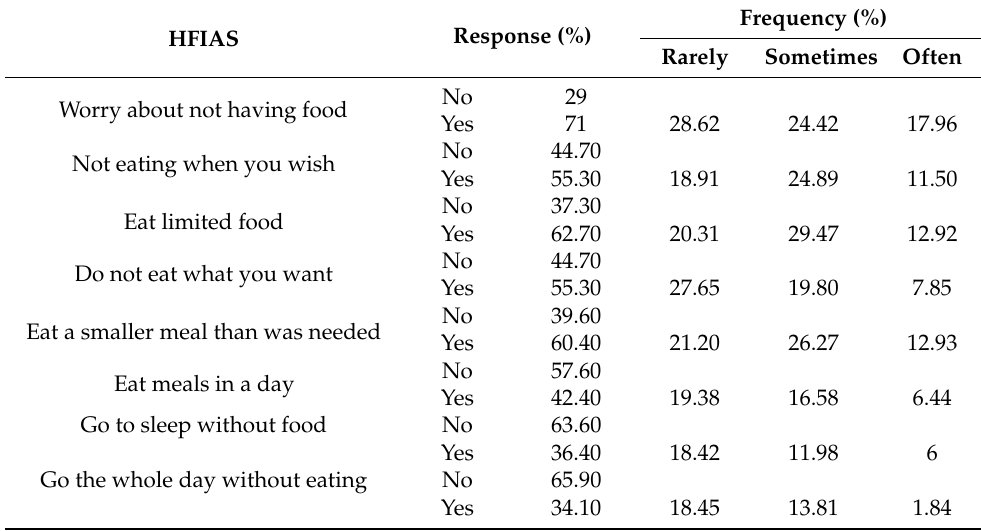
Table 4. Household food insecurity access scale (HFAIS) of smallholder livestock farmers in the Northern Cape Province of South Africa during a drought